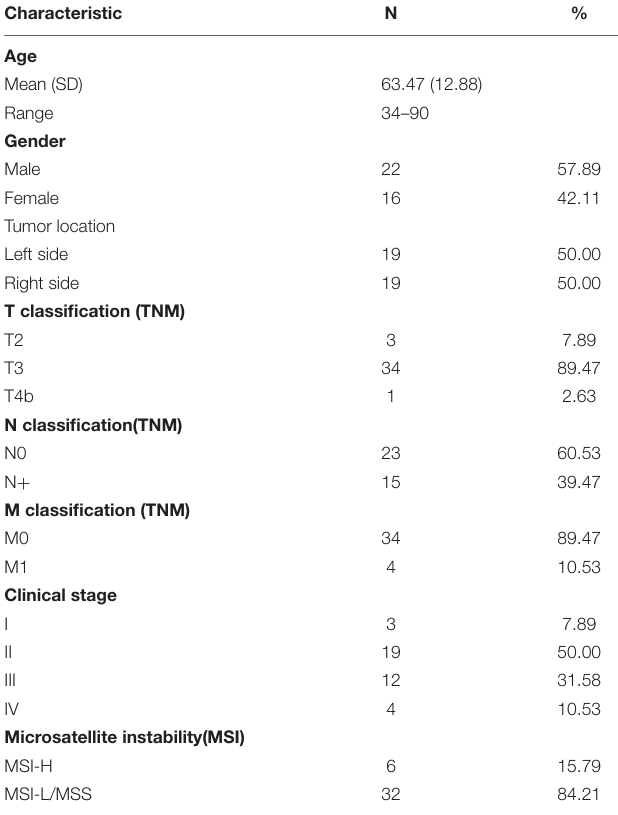
TABLE 1 | Clinical characteristics of CRC